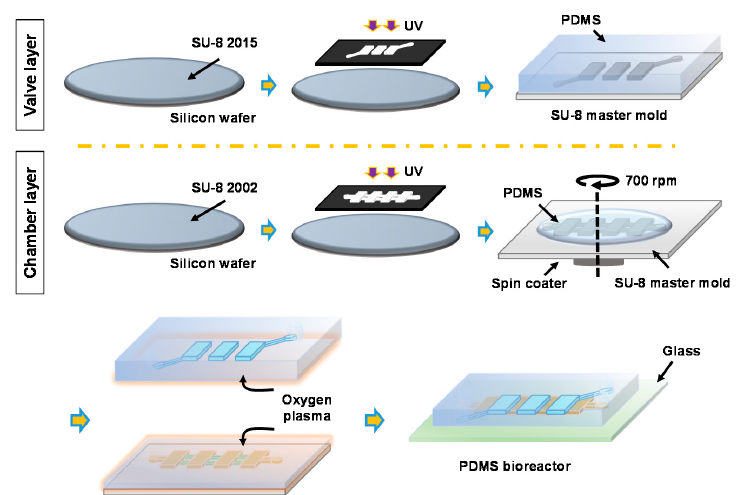
Figure 2. Fabrication process of the PDMS bioreactor.